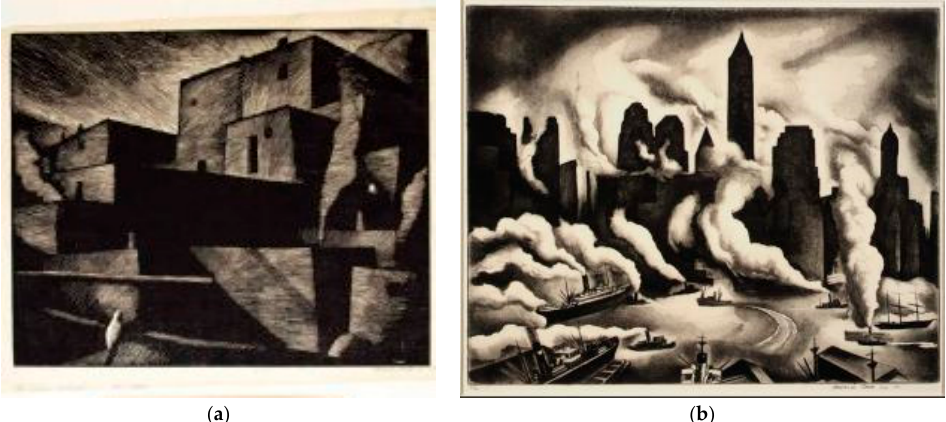
Figure 2. A widely traveled artist, Cook primarily divided his time between New Mexico and